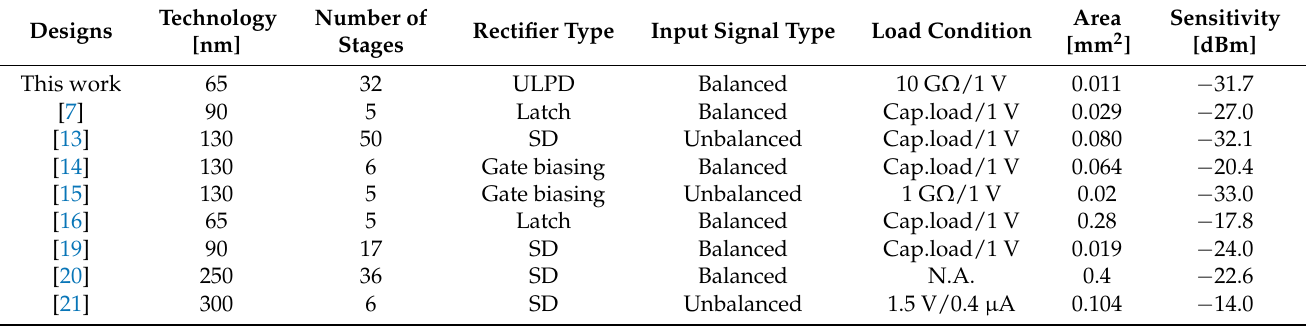
Table 6. Comparison with previous